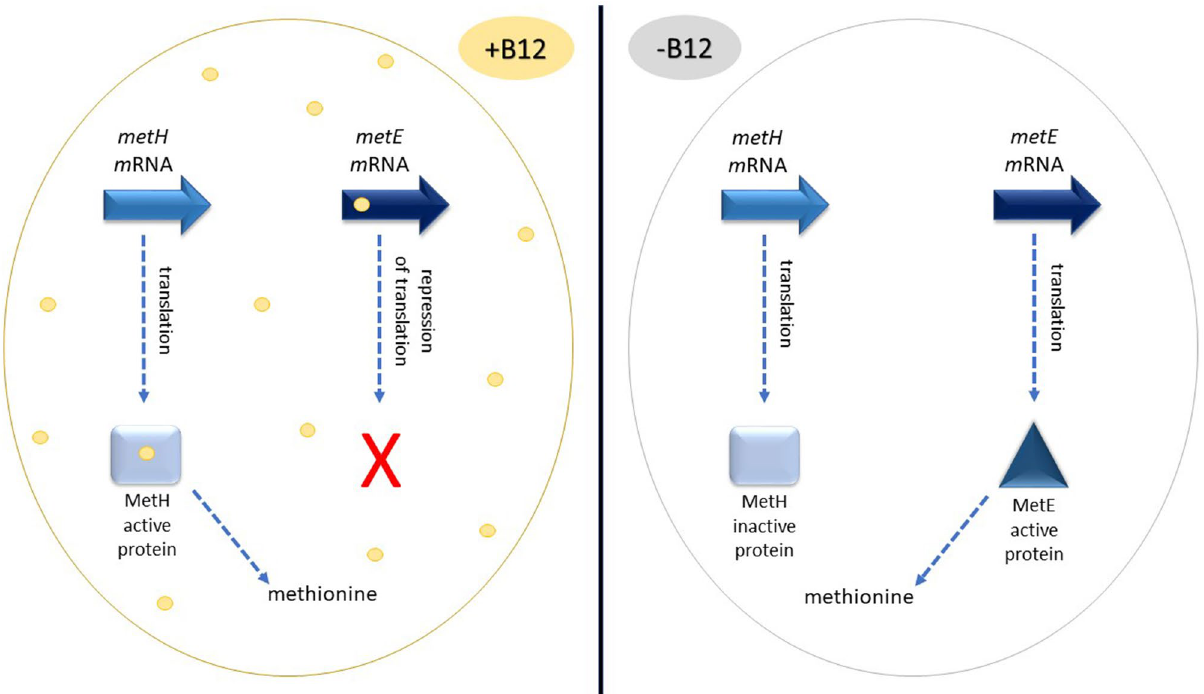
Figure 2. Synthesis of methionine in M. tuberculosis . In the presence of vitamin B12 the riboswitch represses the translation of mRNA of metE . Cobalamin binds as a cofactor to MetH protein, and the latter provides methionine necessary for the cell. In turn, in the absence of vitamin B12, MetH is not functional. metE transcripts are efficiently transcribed to MetE protein, which provides